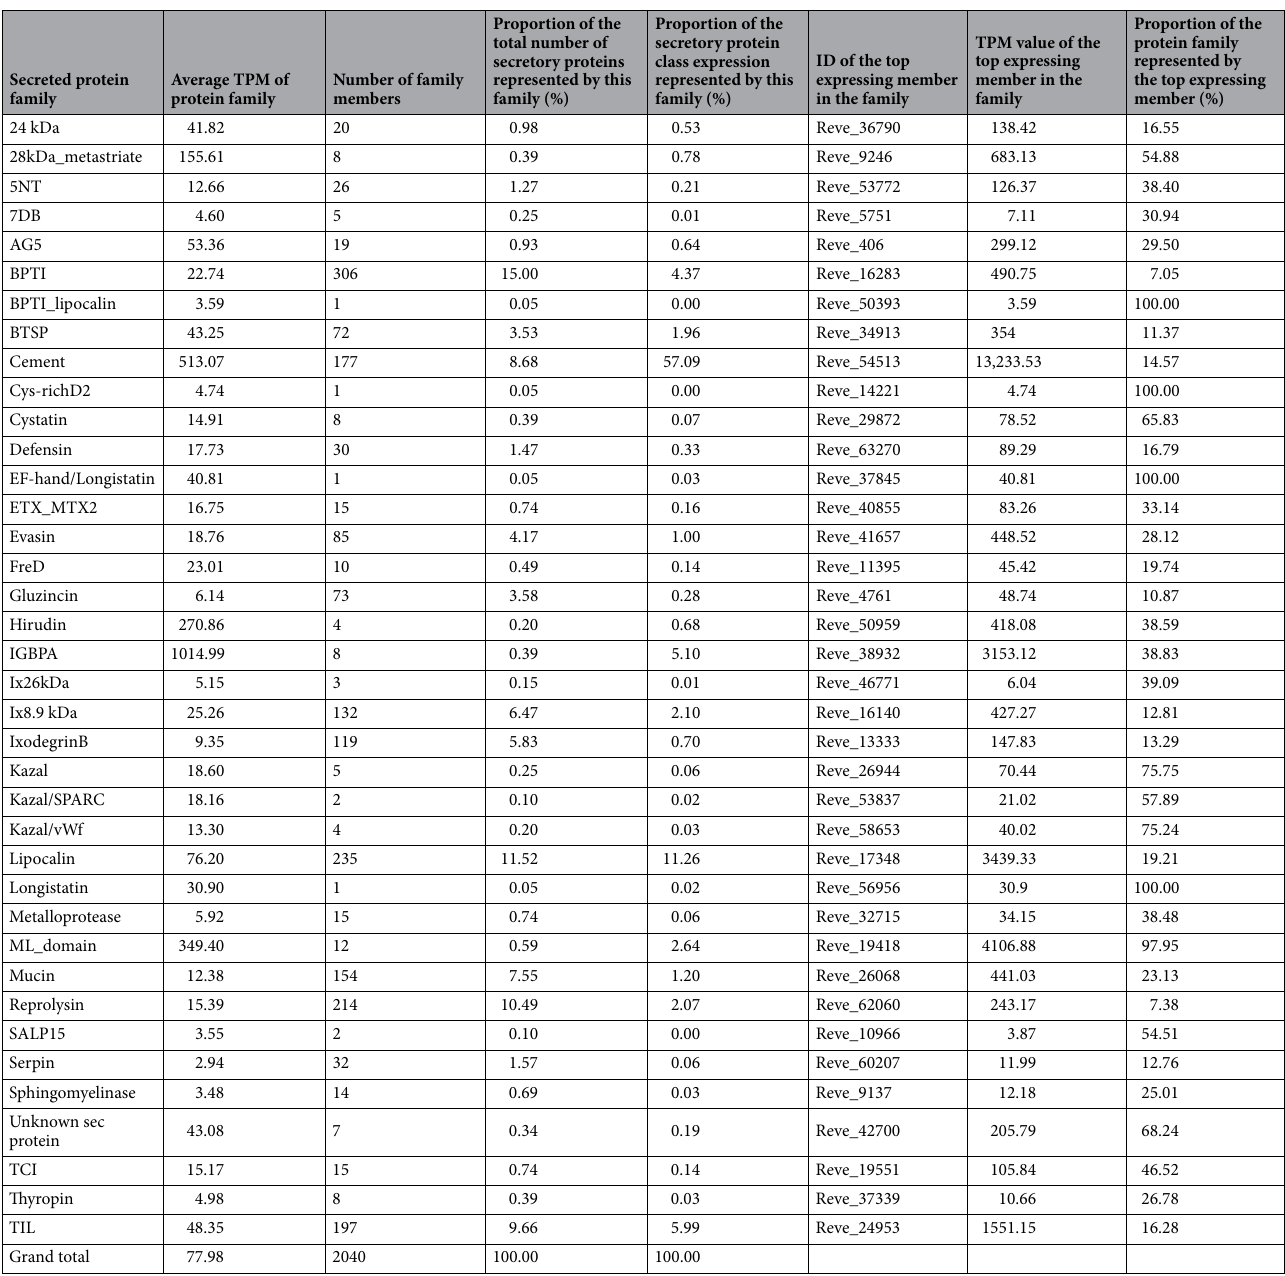
Table 1. Characteristics of major tick secretory protein family expression in the Rhipicephalus evertsi evertsi